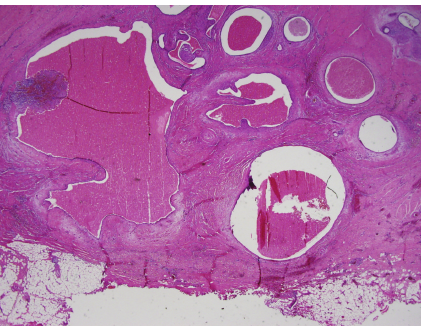
Figure 2: Endometrial glands, stroma, and adipose tissue were found within the connective tissue. H&E staining, × 10 magnifica-